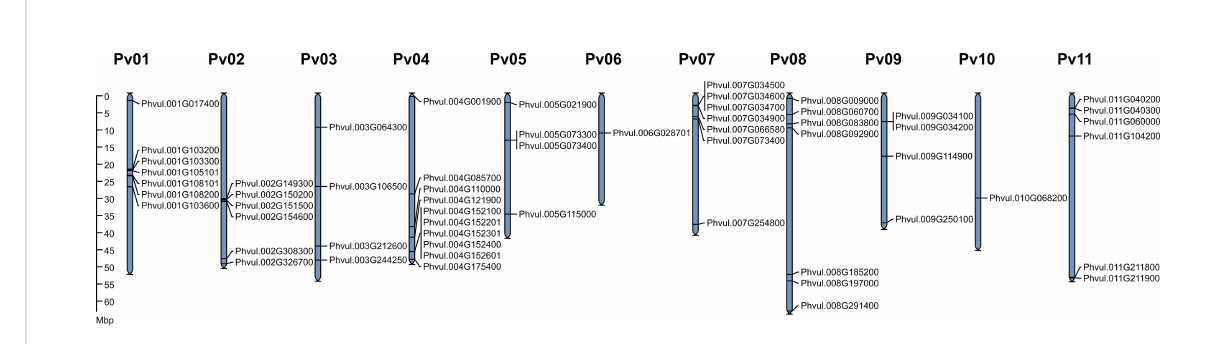
FIGURE 3 Genomic distribution of PvMATE genes in P. vulgaris landrace G19833 chromosomes. The chromosome numbers are indicated above each chromosome and drawn to a scale in megabase pairs (Mbp). The chromosome size is indicated by its relative length using the information from Phytozome